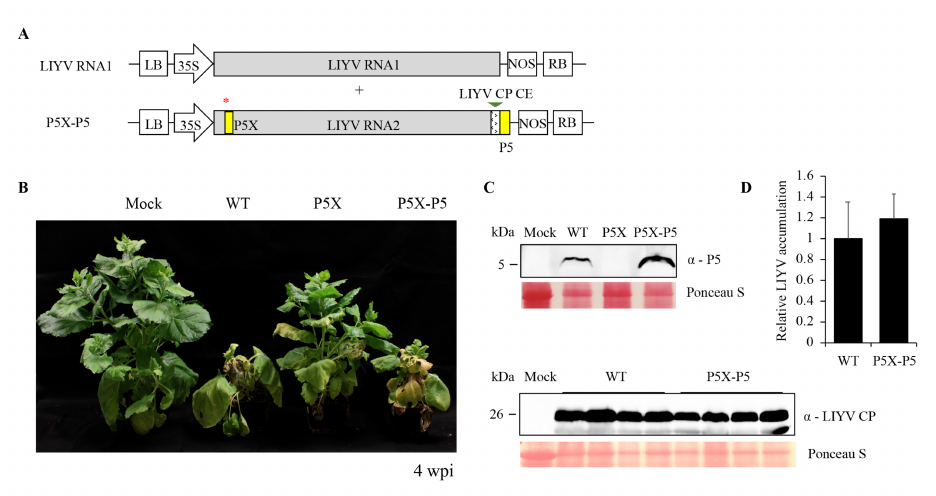
Figure 5. LIYV P5 mutant (P5X) complemented by a translocated P5 (P5X-P5) in the LIYV genome. ( A ) Schematic diagram of the genome organization of the P5X-P5 construct. The P5 gene controlled by a LIYV CP controller element (CE) was inserted between the P26 ORF and 3 (cid:48) -nontranslated region (NTR) of LIYV RNA2. The red * indicates the mutated P5 gene. ( B ) Phenotypes of LIYV WT, P5X and P5X-P5 agroinoculated N. benthamiana plants photographed at 4 wpi. ( C ) Immunoblot